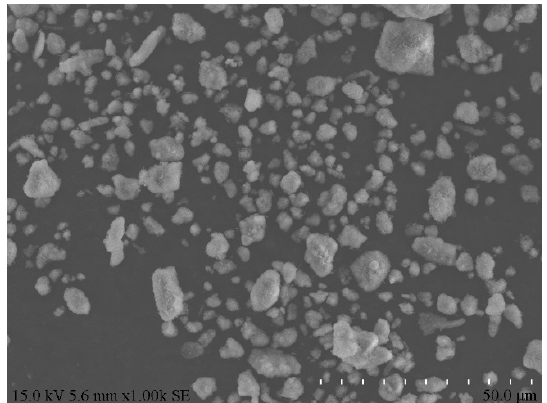
Figure 3. Morphology of aluminum ash.